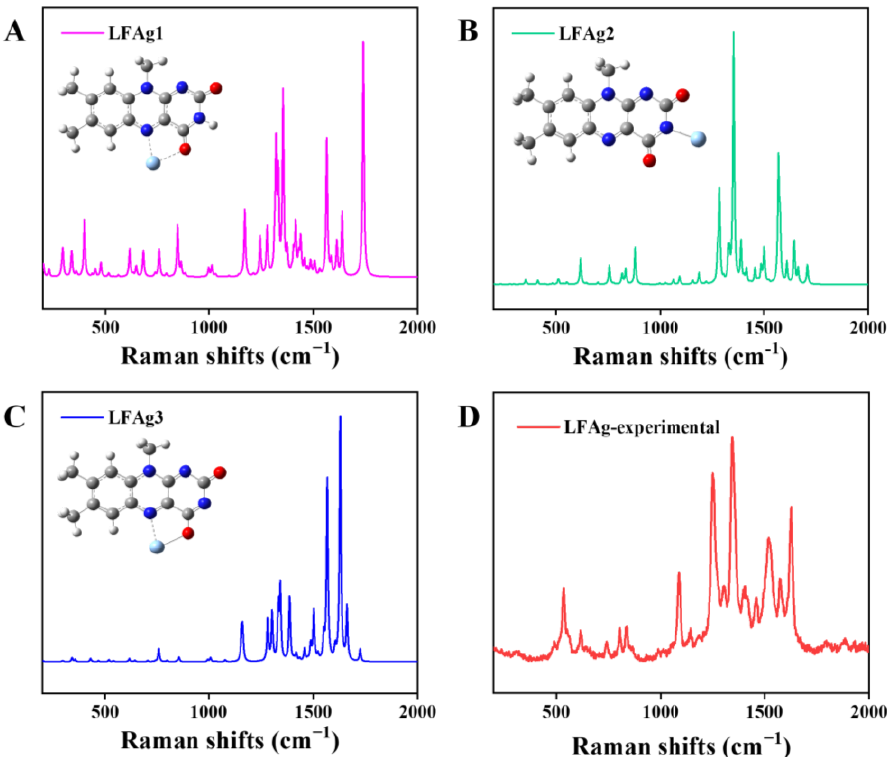
Figure 4. The DFT calculations three complexes ( A – C ) of LF combined with Ag atom and the experimental SERS spectrum ( D ) of LFAg.